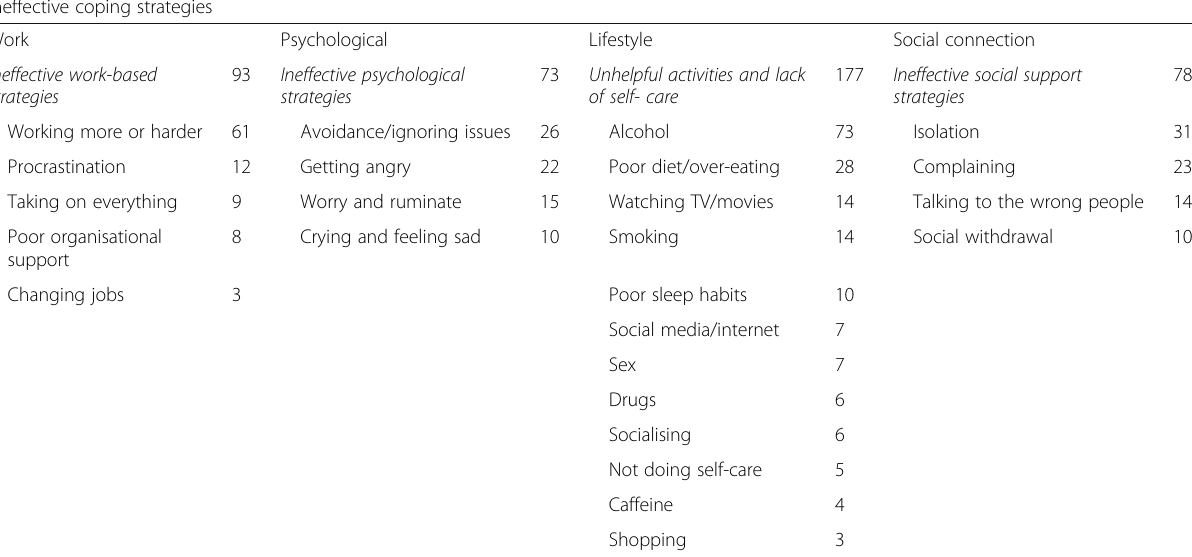
Table 3 Ineffective coping strategies code frequency grouped by four overarching themes Ineffective coping